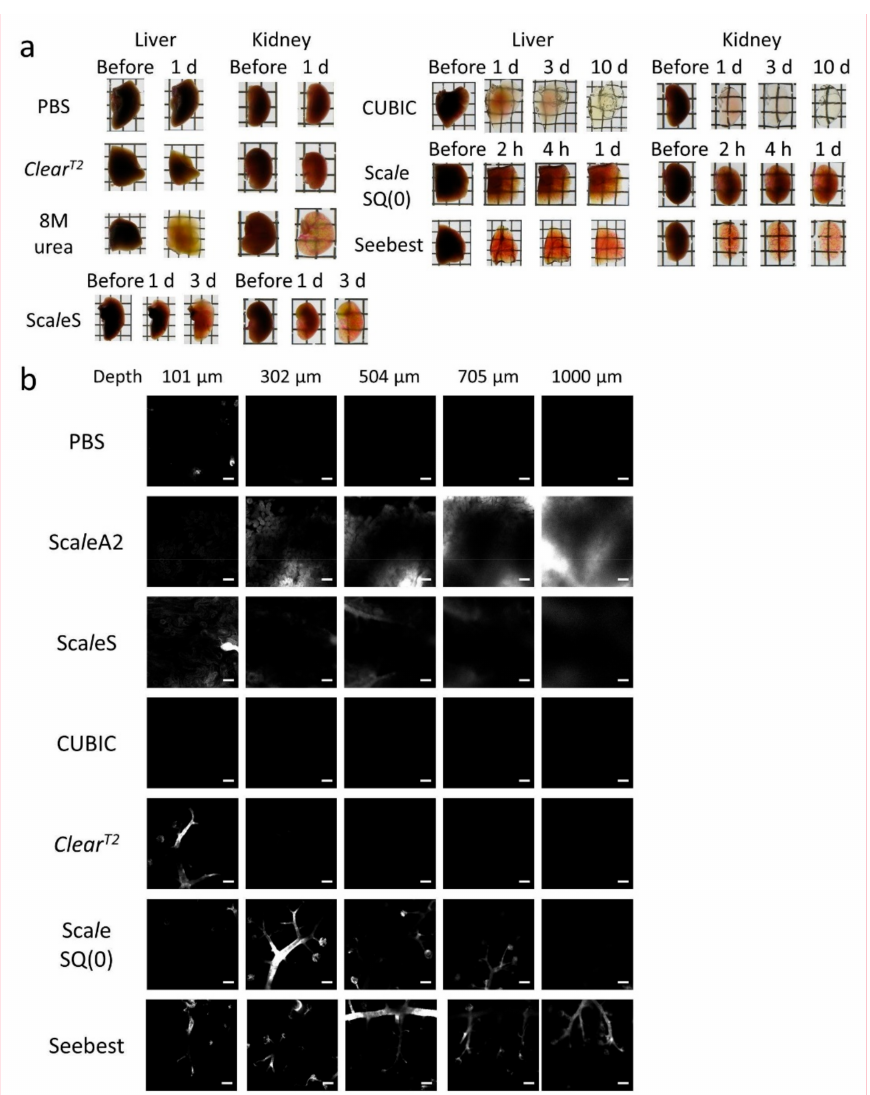
Figure 2. Comparison of tissue clearing methods. ( a ) Murine liver and kidney cleared by various tissue clearing methods. Each lattice was 4 mm wide and 4 mm high. ( b ) Observable depths of blood vessels in the kidney of DiI-perfused mice. Fluorescence images were acquired as a z-stack at 6.714- µ m